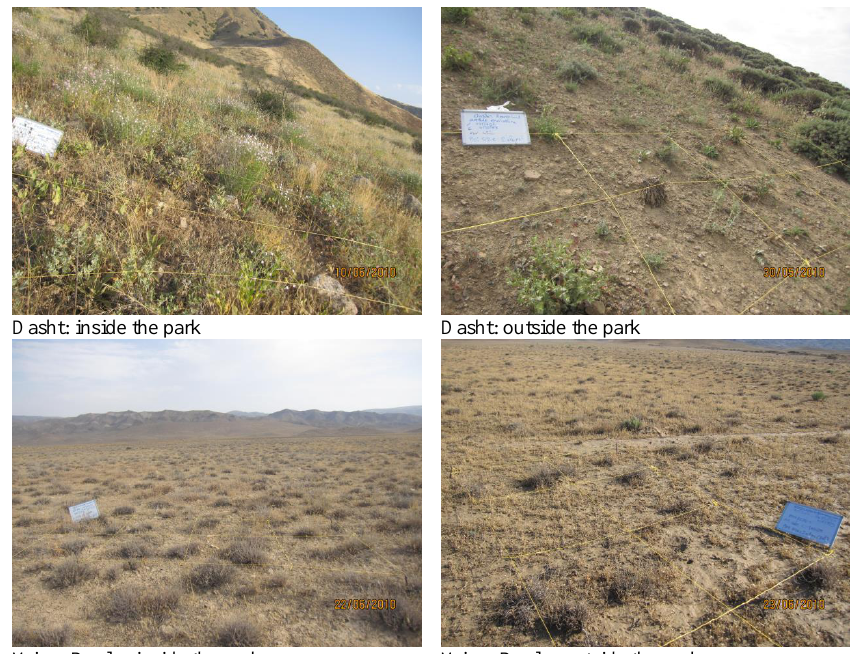
Figure 2. View of vegetation in the study